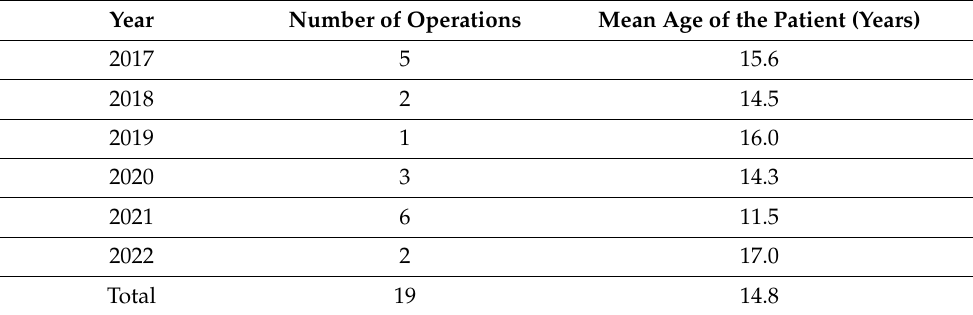
Table 1. Number of operations through the years.